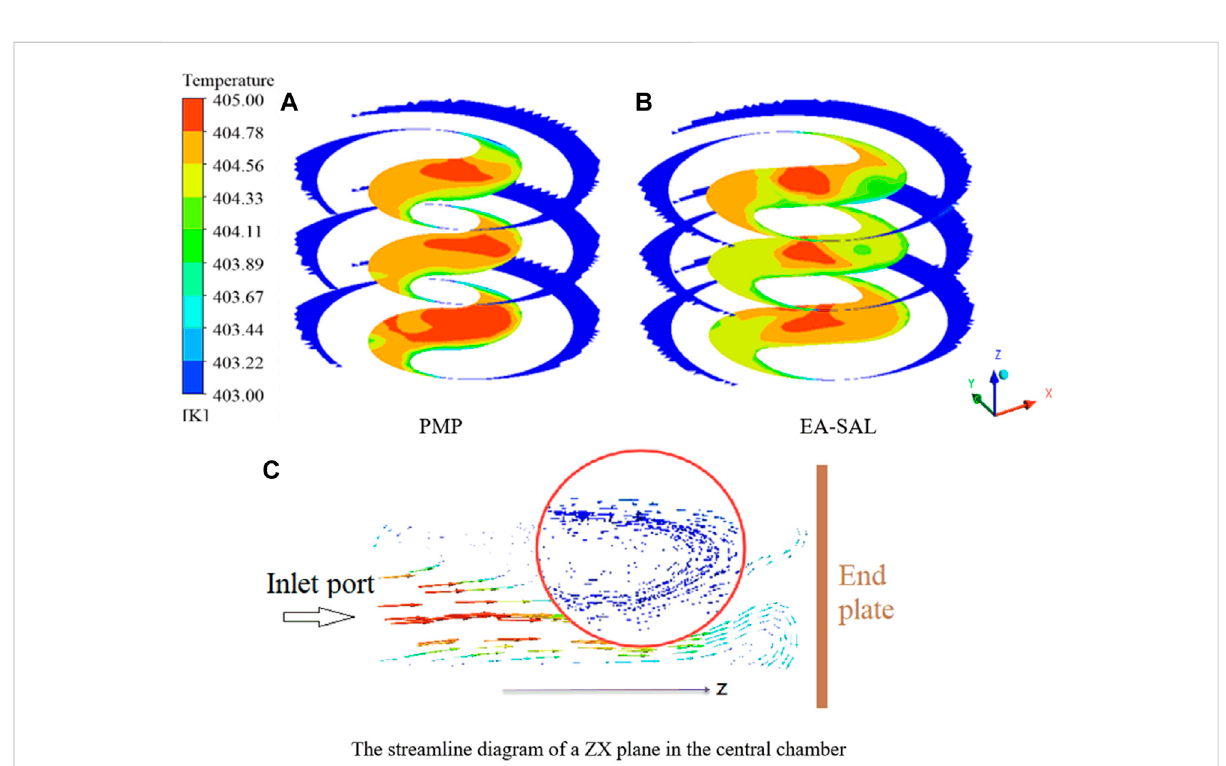
FIGURE 7 (A,B) are the temperature distribution of the central suction chamber of the tooth head after PMP correction and EA-SAL correction at 180 ° angle, respectively; (C) is the streamline diagram of ZX plane of central chamber.